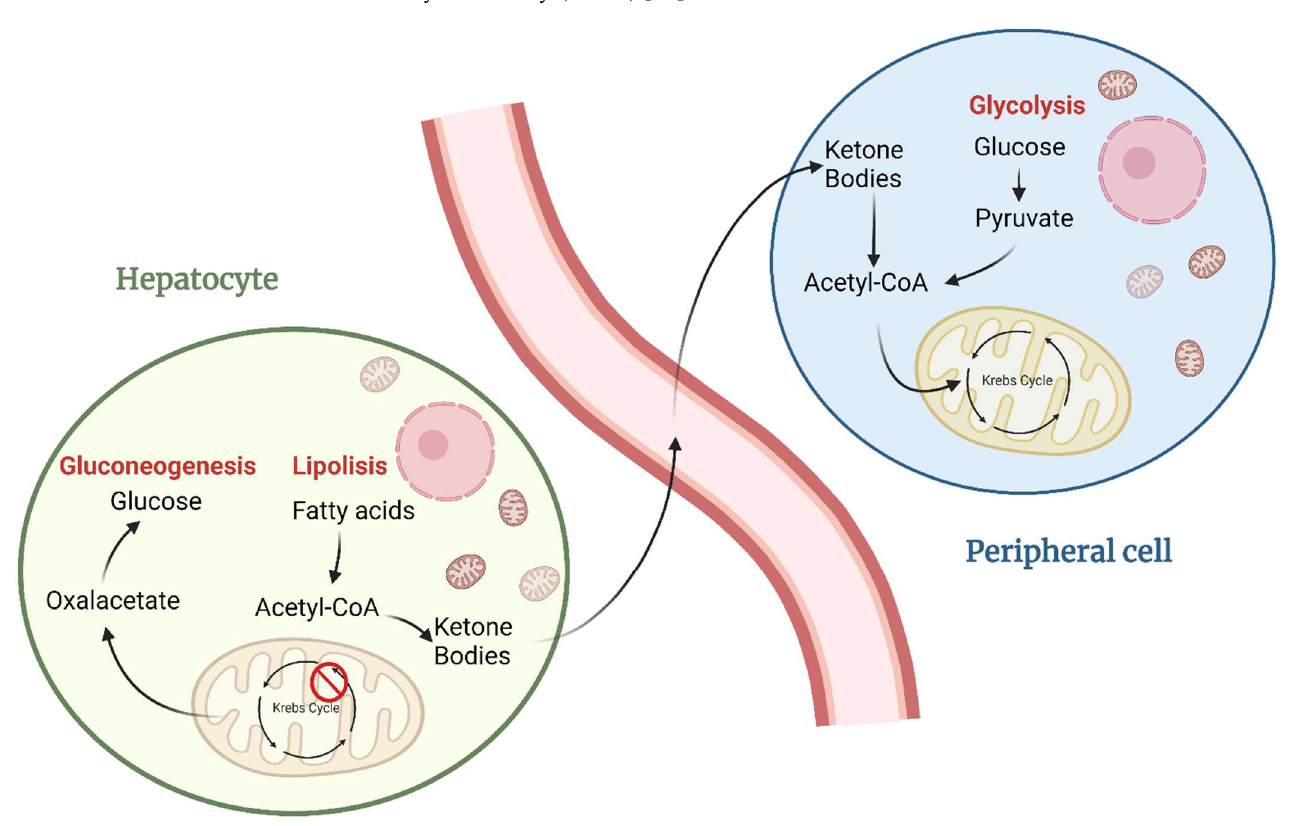
Figure 2. Mechanism of action in the production and utilization of ketone bodies.